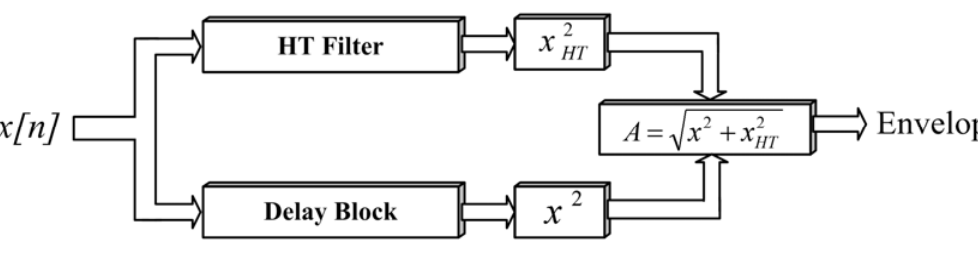
Figure 5. Hilbert transform tracking of the voltage